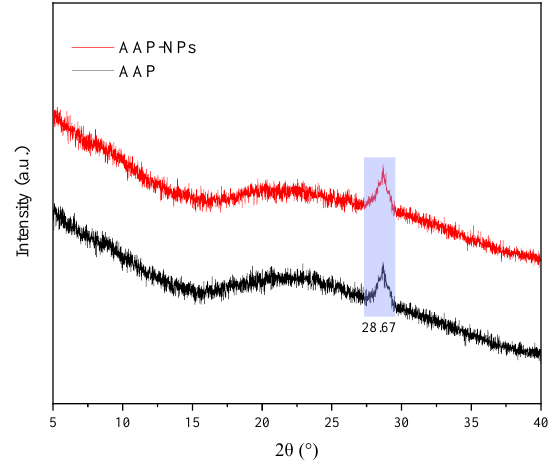
Figure 6. X-ray diffractograms of AAP-NPs and AAP.